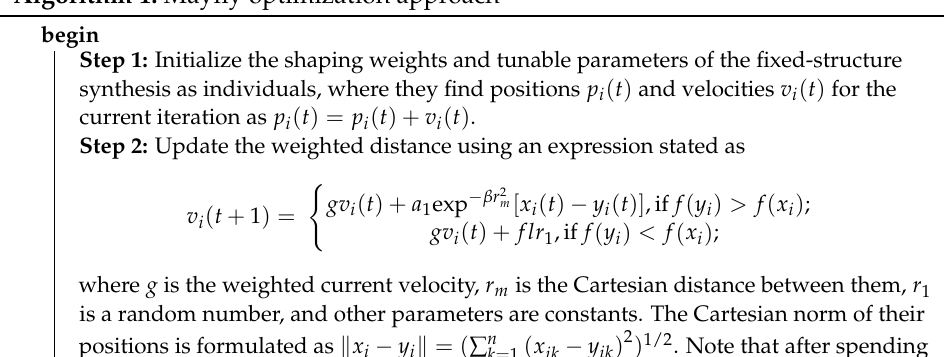
Algorithm 1: Mayfly optimization approach